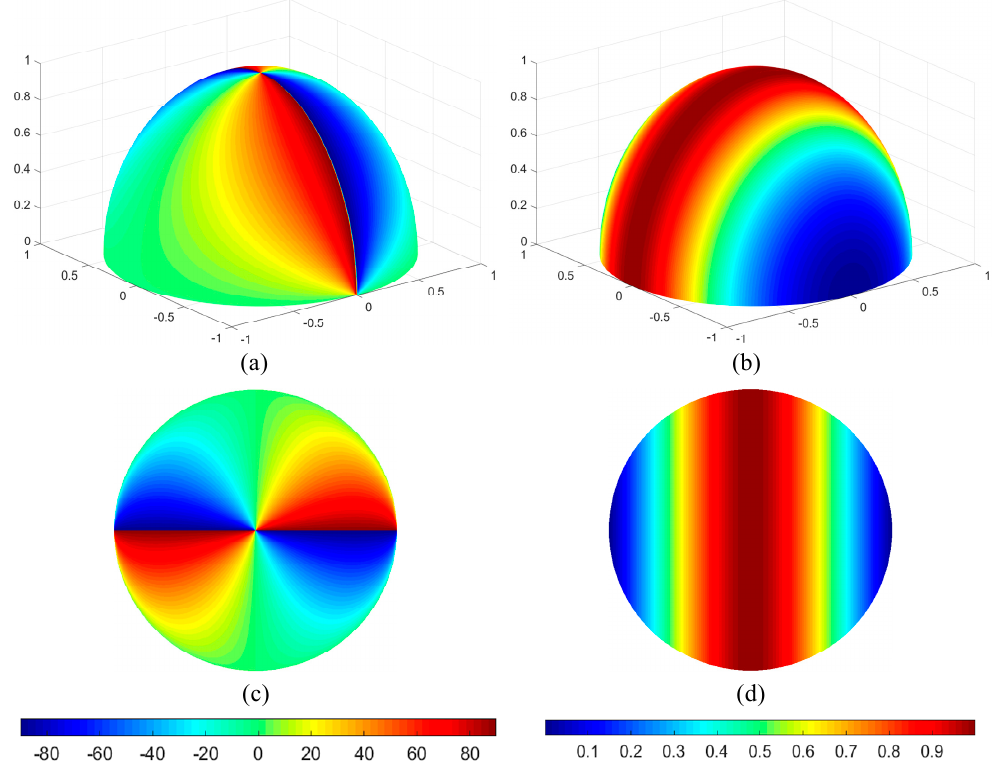
Figure 3. The Rayleigh model. ( a ) The Aop (angle of polarization) distribution of the Rayleigh model; ( b ) the Dop (degree of polarization) distribution of the Rayleigh model; ( c ) two-dimensional representation of the Aop of the Rayleigh model; ( d ) two-dimensional representation of the Dop of the Rayleigh model.